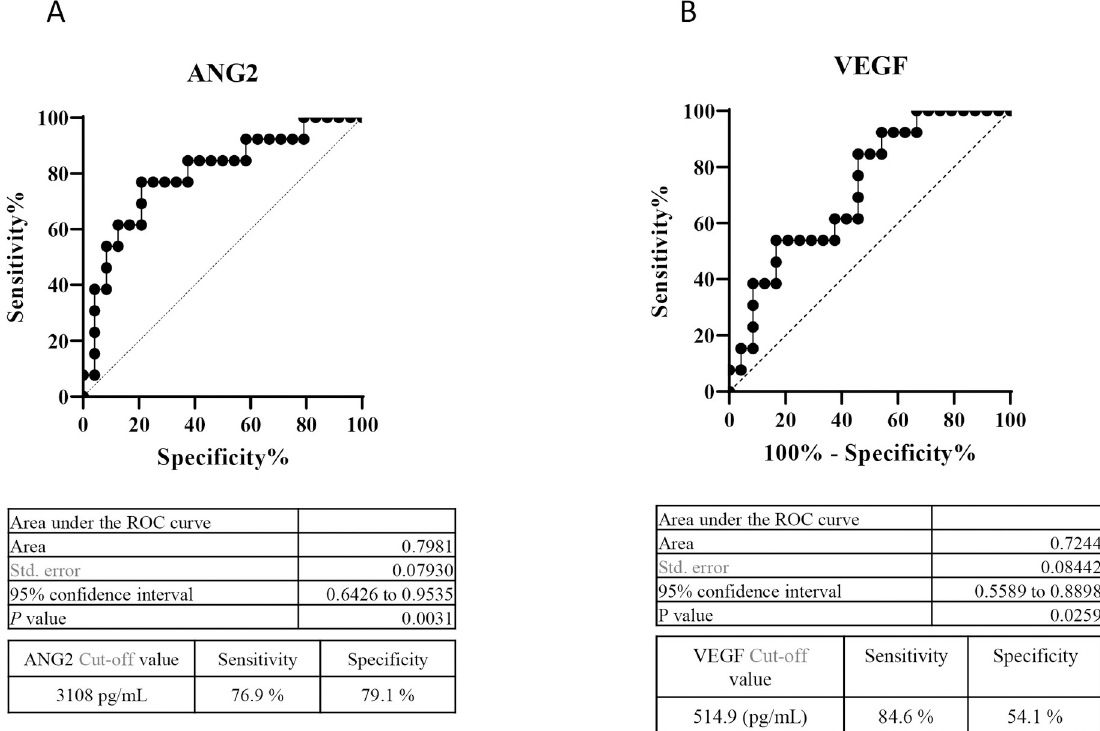
Fig 3. Cut-off values of baseline serum ANG2 and VEGF levels for predicting a reduction in the Child-Pugh score at 8 weeks after lenvatinib initiation. A. ROC curve analysis of baseline ANG2 levels in patients treated with lenvatinib. The cut-off baseline ANG2 level associated with a deteriorated Child-Pugh score at 8 weeks after lenvatinib initiation was 3,108 pg/mL (AUC = 0.772; sensitivity: 75.0%; specificity: 81.8%). B. ROC curve analysis of baseline VEGF levels in patients treated with lenvatinib. The cut-off baseline VEGF level associated with a deteriorated Child-Pugh score at 8 weeks after lenvatinib initiations was 194 pg/mL (AUC = 0.869; sensitivity: 75.0%; specificity: